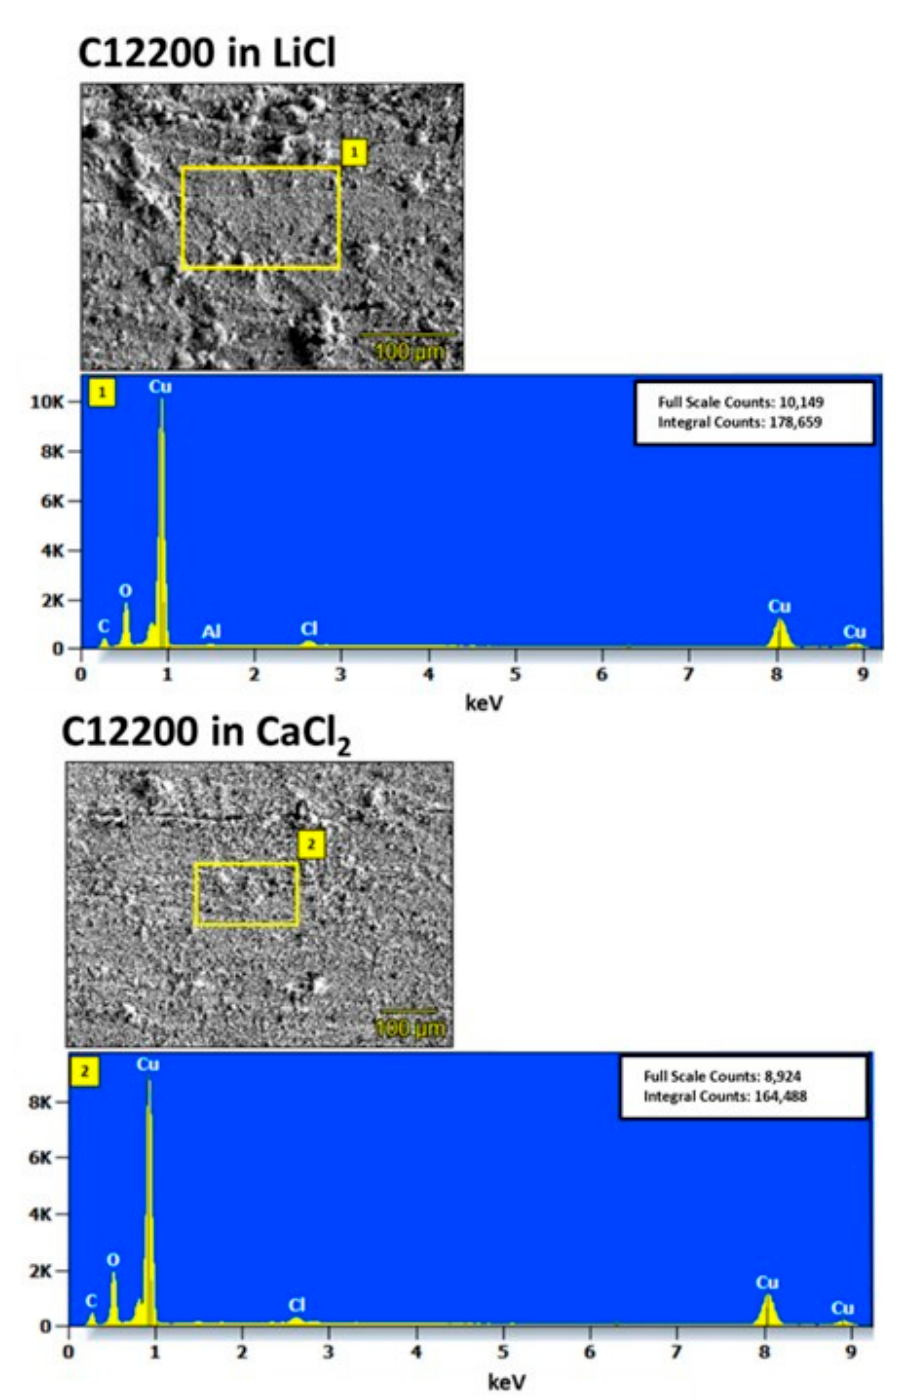
Figure 9. FESEM-EDX surface analysis of C12200 samples after electrochemical corrosion experiment in 30 wt. % LiCl solution and 40 wt. % CaCl 2 solution at 80 ◦ C. The surface composition was relatively homogenous, primarily composed of Cu, with some evidence of oxide formation.